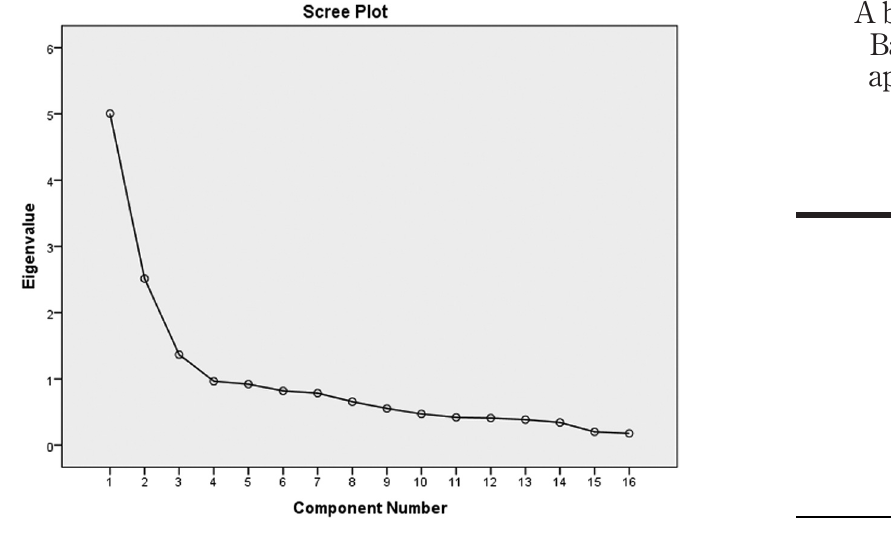
Figure 2. Scree plot